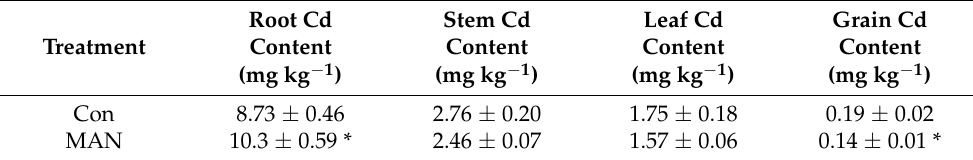
Table 4. Effects of MAN on the Cd content in different parts of wheat in potted soil experiments. Root Cd Treatment